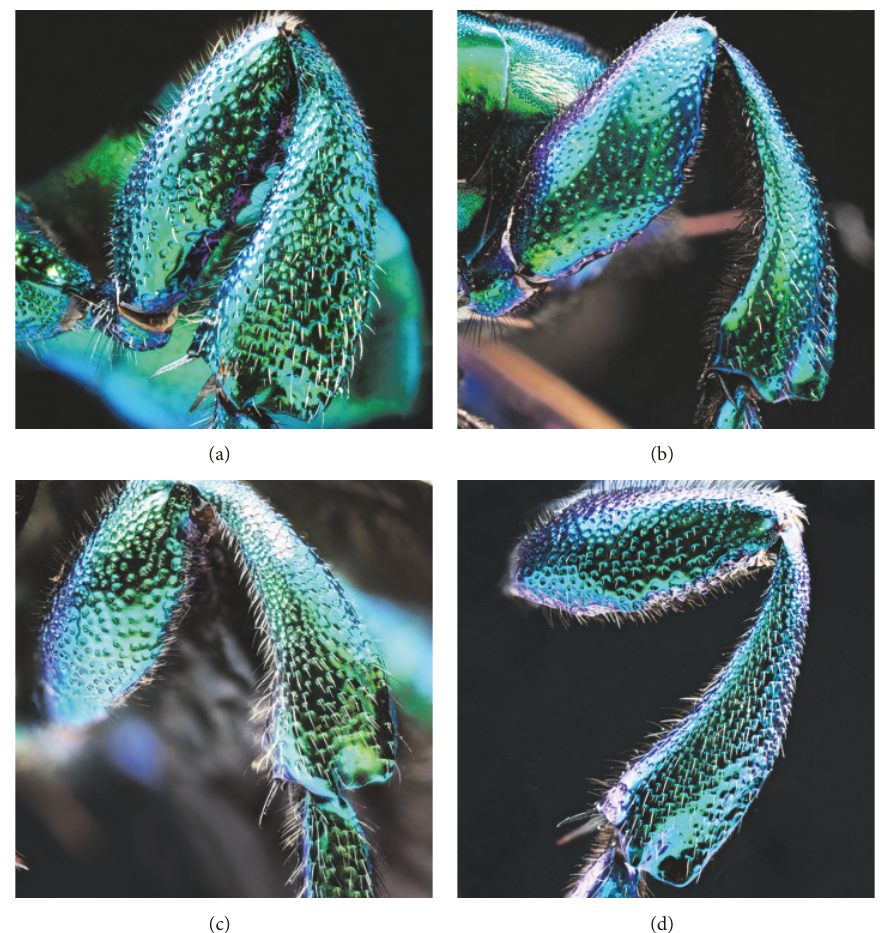
Figure 4: Female hind legs of parasitic euglossines. (a) E. dentata; (b) E. lepeletieri; (c) E. frontalis; (d) E. smaragdina .